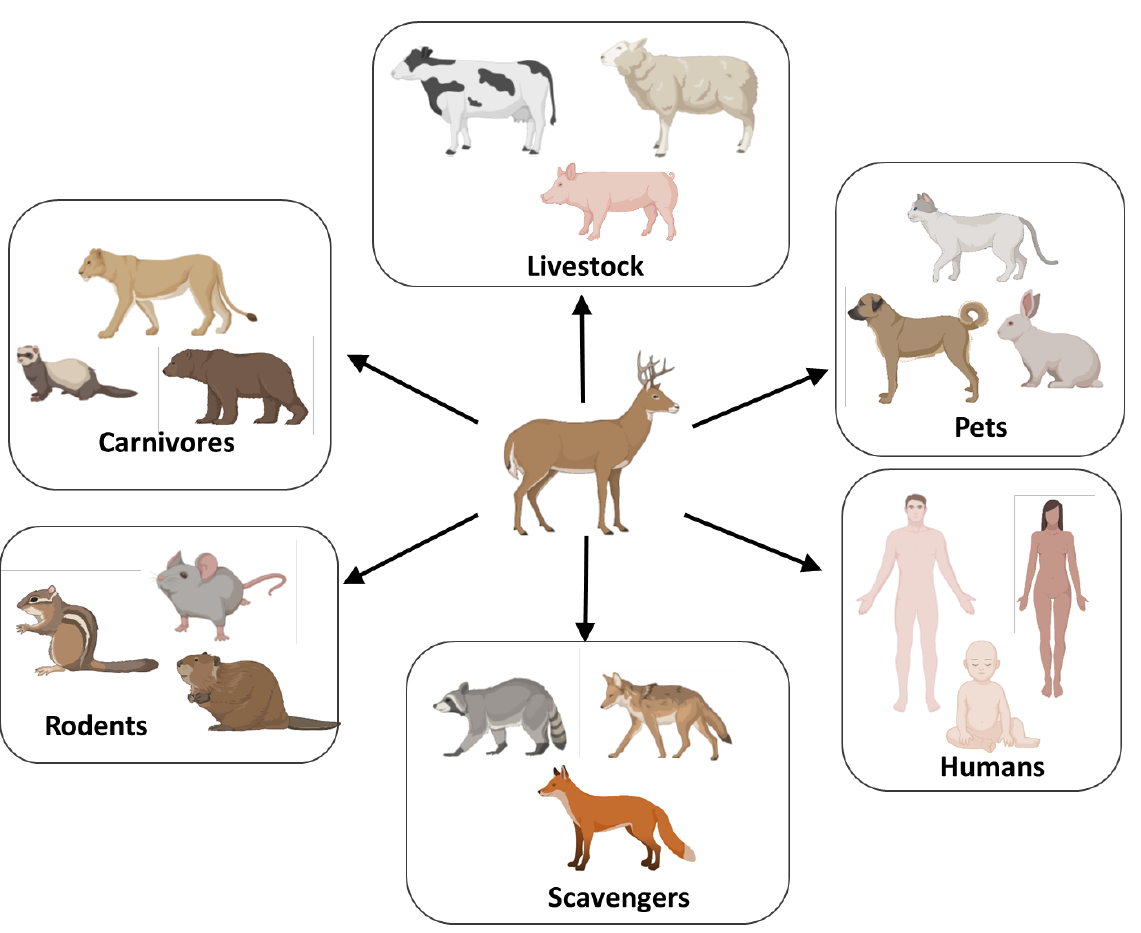
Figure 2. Animal species susceptible or at risk to be infected with CWD. Various animals cohabit with cervid, including livestock, rodents, scavengers, carnivores, domestic animals, and humans. Several studies of experimental infection of animals by CWD have shown that sheep, goats, cattle, ferrets, raccoons, and rodents can be infected with CWD [88 – 94].